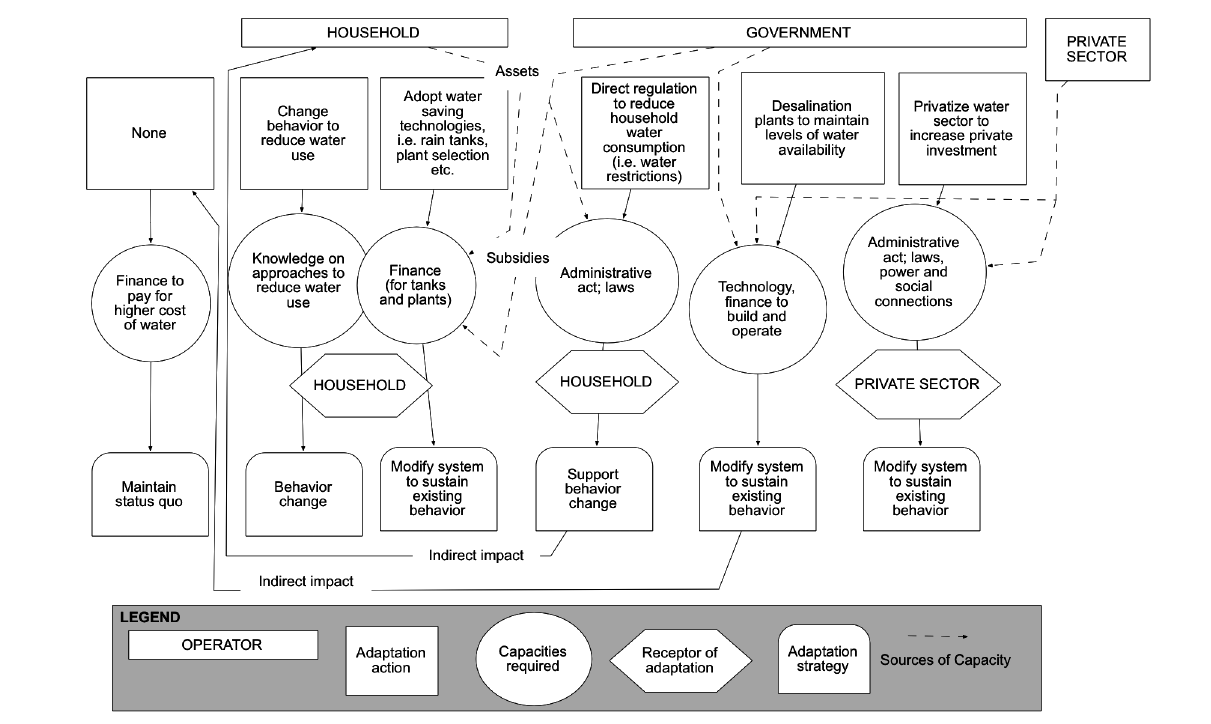
Fig. 3. Indicative example of progressing through the themes that facilitate boundary critique for the assessment of household adaptive capacity. Adapted from Eisenack and Stecker